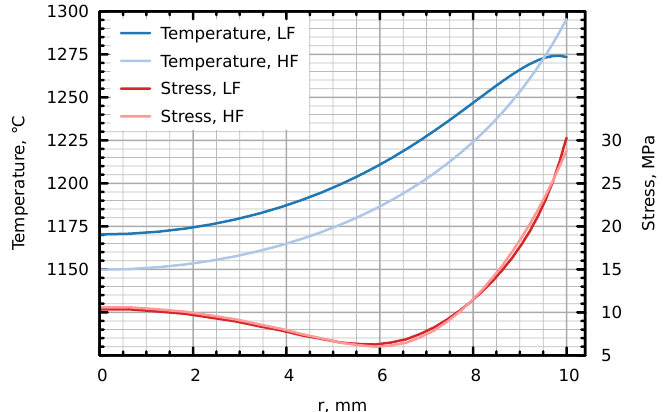
√ J 2 at the end of heating